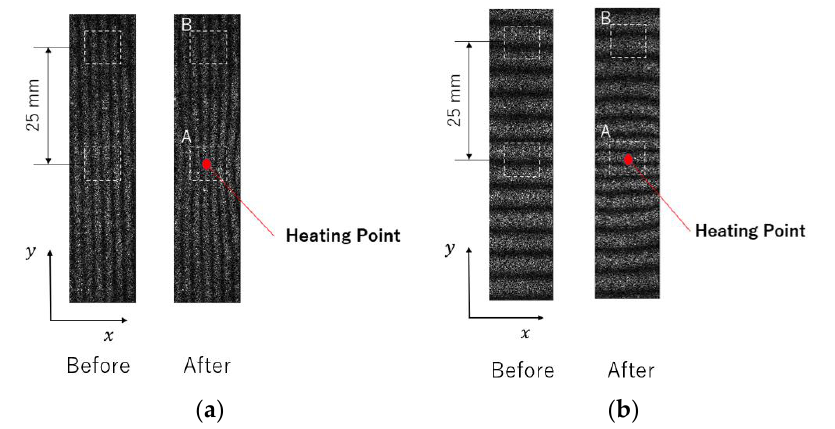
Figure 14. ( a ) Log (strain) – time curve; and ( b ) 𝐶𝐸𝑅 – initial stress curve.